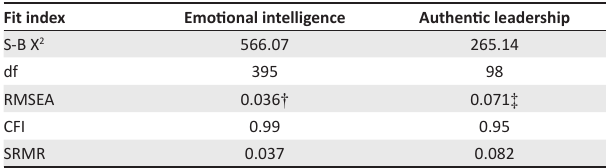
TABLE 2: Goodness-of-fit